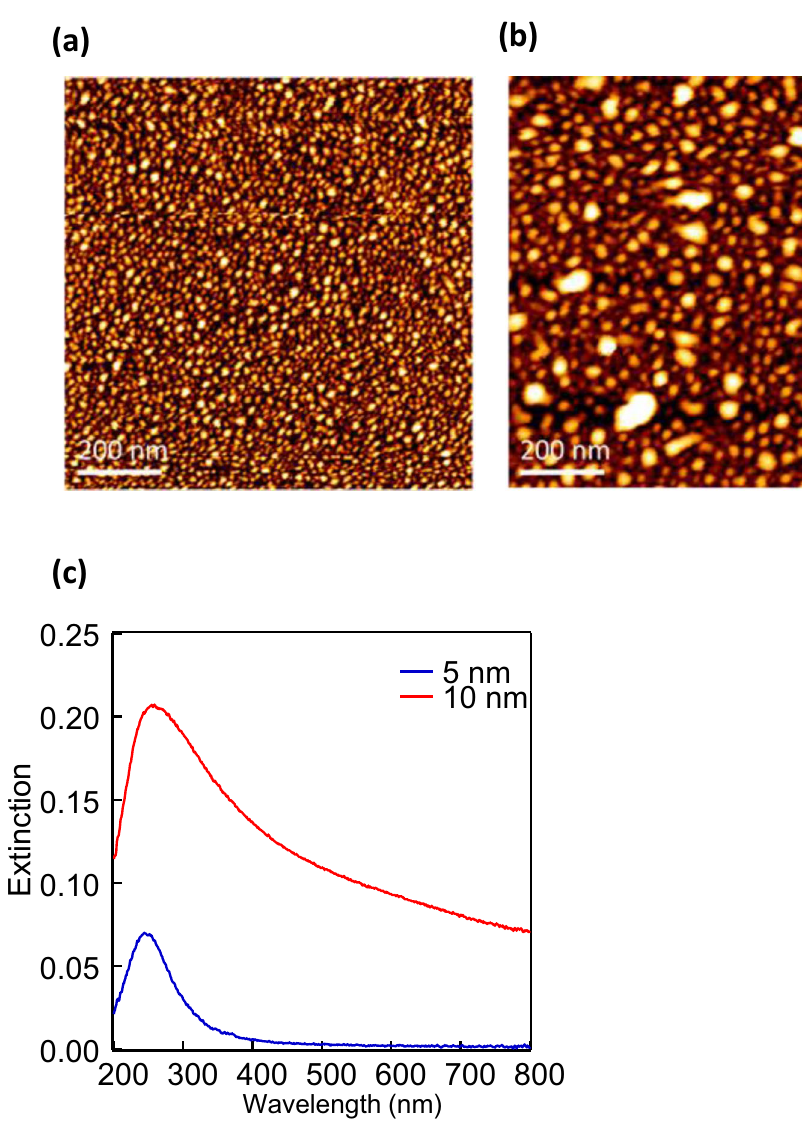
Figure 5. Al nanostructures fabricated by thermal annealing process and its LSPR spectra. AFM images of the Al thin films with ( a ) 5 nm and ( b ) 10 nm after annealing. ( c ) Experimental extinction spectra of 5 and 10 nm Al after